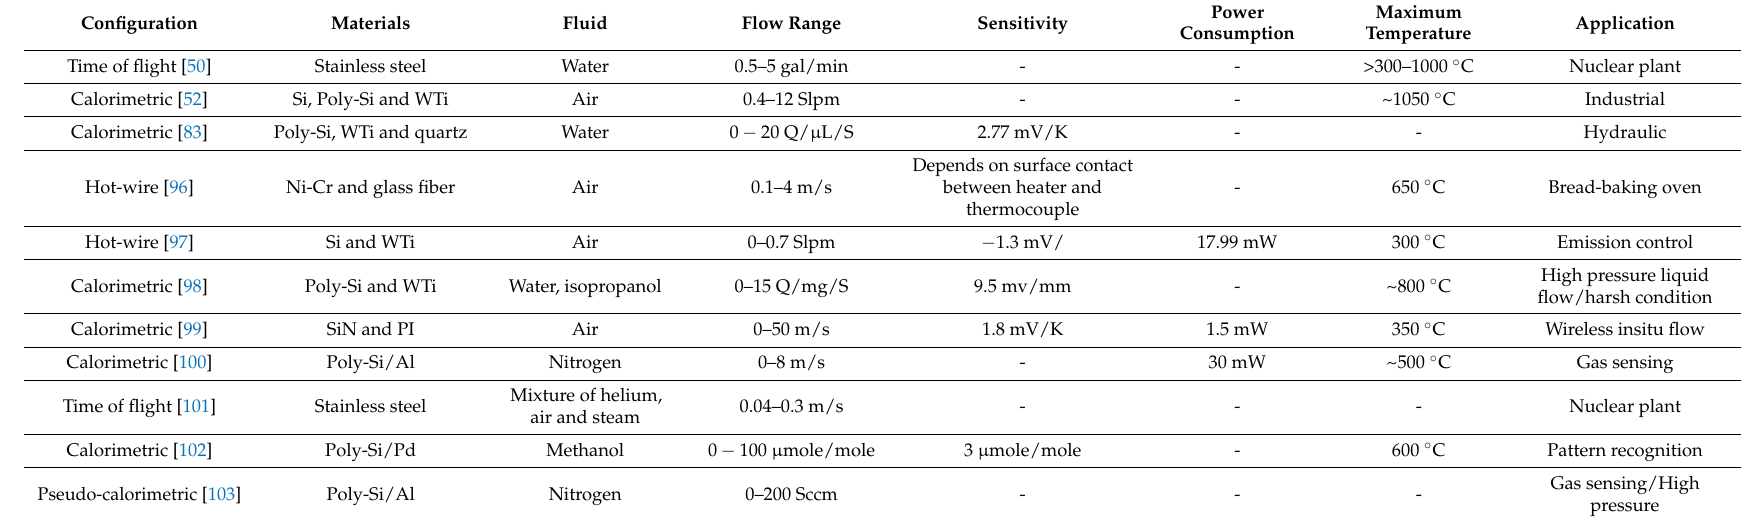
Table 4. Typical research results of thermoelectric flow